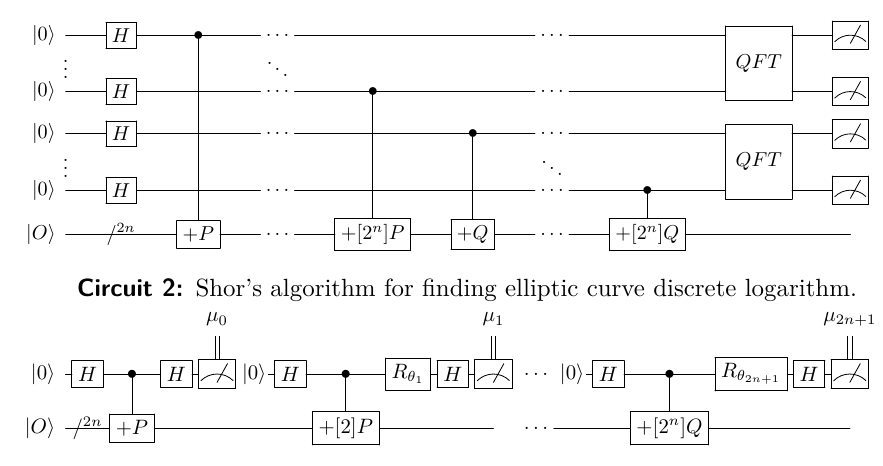
Circuit 3: Shor’s algorithm for finding elliptic curve logarithms with a semiclassical Fourier